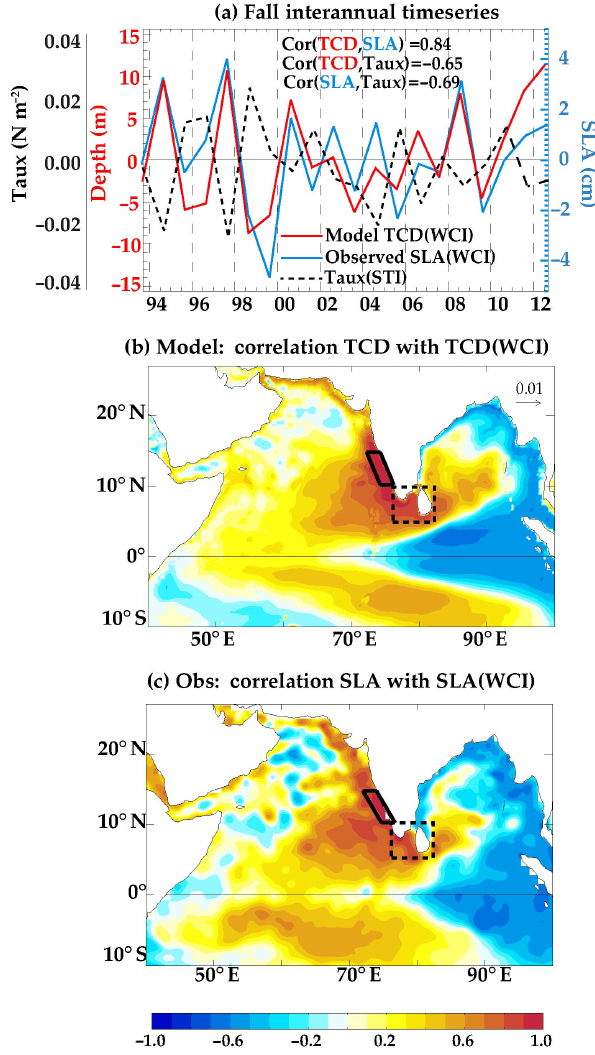
Figure 9. (a) Fall interannual anomalies of the model thermocline depth (red line) and the altimetry-derived sea level (blue line) aver- aged over the WCI box (see black frame in panels b and c ) along with fall interannual zonal wind stress anomalies (dashed black line) averaged over the STI box (see dashed frame in panels b and c ). (b) Correlation pattern of fall interannual thermocline anomalies with that averaged over the WCI box in the model. (c) Same as (b) but for altimetry-derived sea-level